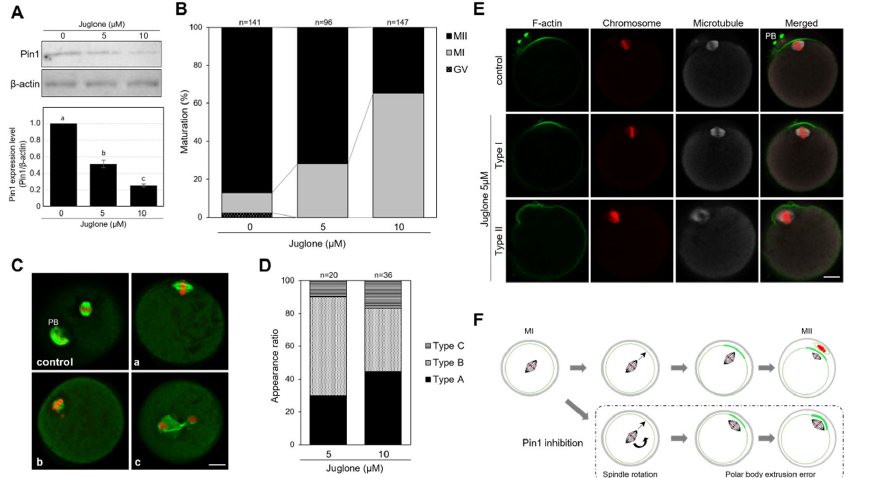
Figure 3. Juglone inhibits meiotic maturation in vitro. ( A ) Expression level of Pin1 after 18 h of juglone treatment. ( B ) Effects of Pin1 inhibition with juglone on meiotic maturation as determined using immunostaining with anti- α -tubulin antibodies and nuclear staining. Graphs showing the percentage of oocytes, with or without juglone treatment, at the germinal vesicle (GV), metaphase I (MI), and metaphase II (MII) stages at 18 h after in vitro maturation (IVM). The inhibition experiment was repeated five times. Graphs show the ratios of the total number. ( C ) Localization of α -tubulin and chromosomes after 18 h of juglone treatment. A photograph of oocytes cultured without inhibitor for 18 h is shown as a control. Most oocytes, after juglone treatment, appeared to be arrested at MI at 18 h after the start of culture with MI spindles parallel to the cortex, weak spindle fibers, and unclear spindle poles (a: type A). Spindles are small, and chromosomes are scattered away from the metaphase plate (b: type B). The polar body is not extruded, and chromosomes are separated in the cytoplasm (c: type C). Green and red indicate α -tubulin and chromosomes, respectively. Scale bar, 20 µ m. PB, polar body. ( D ) Graphs showing the ratios of Type A, B, and C oocytes that stopped at the MI phase and could not extrude the first polar body following juglone treatment at 18 h after IVM. ( E ) Localization of actin cap using F-actin staining, 18 h after IVM. The control oocytes show polar body extrusion and strong localization of actin near the MII spindle. After treatment with 5 µ M juglone, the spindle is localized to the nearest site on the cortex, but the first polar body is not extruded even with the formation of the actin cap. In type I oocytes, the MI spindle appeared parallel to the cortex. In type II oocytes, the rotated spindle did not release the polar body even after a few hours. Green, red, and gray indicate F-actin, chromosomes, and microtubules, respectively. ( F ) Schematic diagram of the effect of juglone treatment on meiosis. The top panel in the figure shows meiosis from normal MI to MII. The lower panel shows the effect of Pin1 inhibition. When Pin1 is inhibited by juglone, the spindle in the MI moves to the cortex but the spindle rotates and is placed parallel to the cortex, such that the release of the polar body is not possible even when an actin cap is formed. Green and red indicate F-actin and chromosome, respectively. Scale bar, 20 µ m. Data represent the mean ± SEM of three replicates repeated in different experiments. Different letters represent significant difference for p <0.05 between